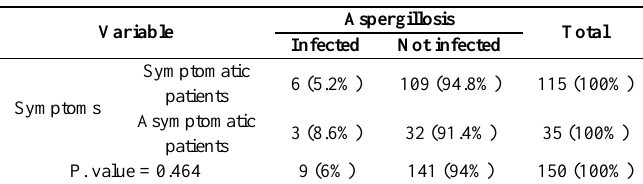
Table 2 : Frequency of aspergillosis among symptomatic and